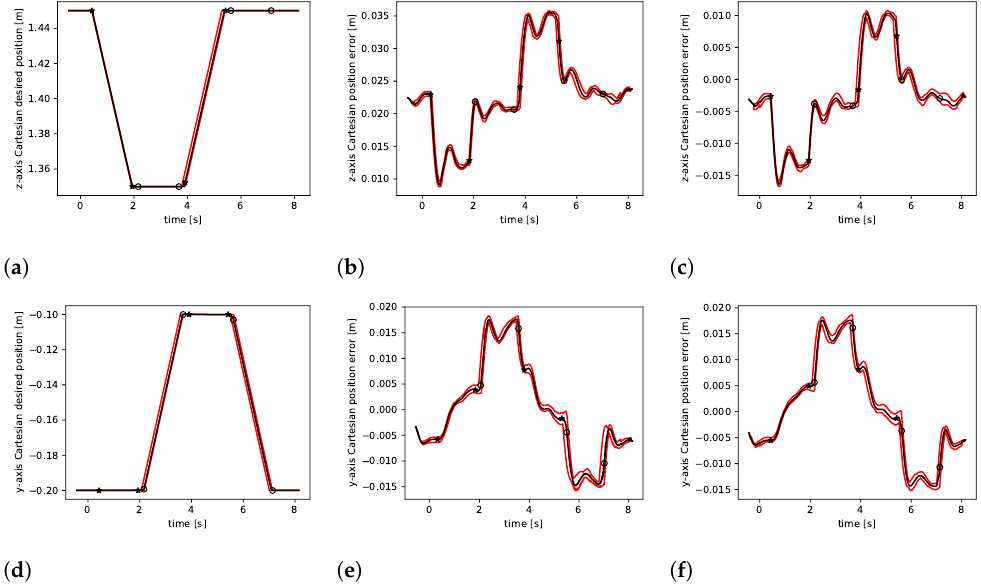
Figure 13. Experiments on the real robot. The plots from control in Cartesian impedance mode with the grasped 2 kg object: ( a , d ) the Cartesian desired positions, ( b , e ) the errors with no compensation, ( c , f ) the errors with object weight compensation. The upper and lower rows concern the z -axis and y -axis, respectively. The black plot is the mean for 15 runs and red plots represent minimum and maximum